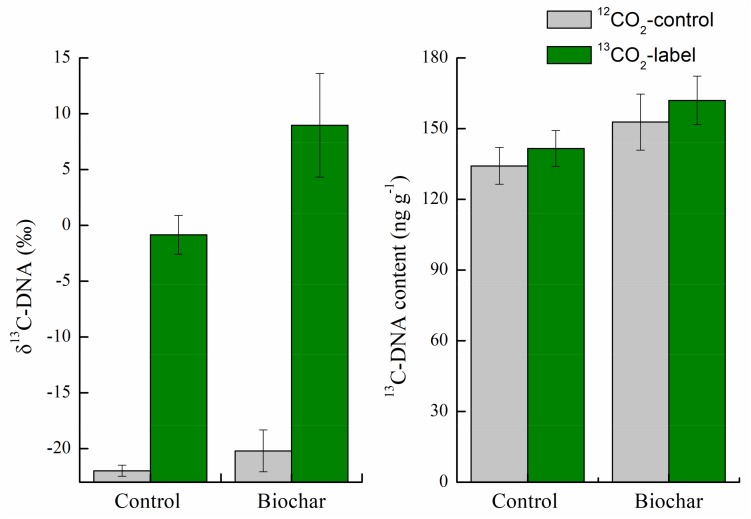
Isotopic signatures of δ13C (‰) and 13C-DNA concentration (ng g–1) in the control and biochar treatments after 35-day of continuous labeling. Bars are means ± SE. Significant differences between treatments were tested by one-way ANOVA with Fisher’s LSD test.